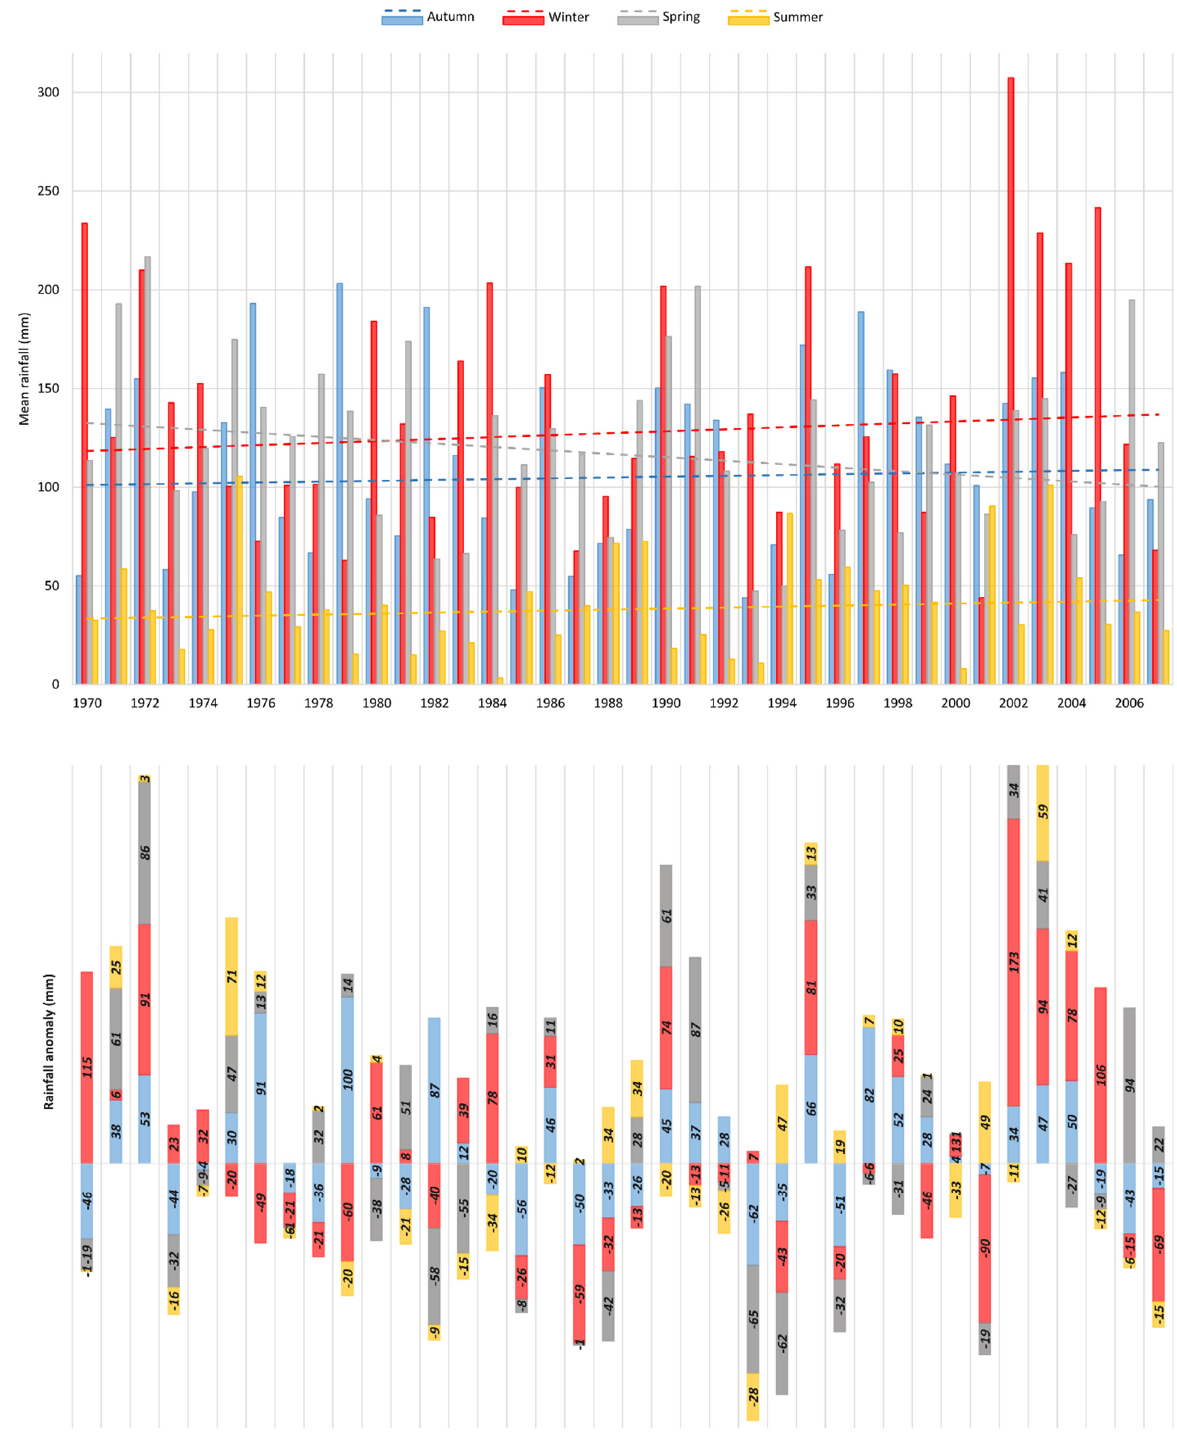
Figure 5. Annual rainfall ( top ) and rainfall anomaly ( bottom ) over the Medjerda watershed at seasonal scale. Dash lines represent trend with Sen’s slopes Temporal trend analysis.